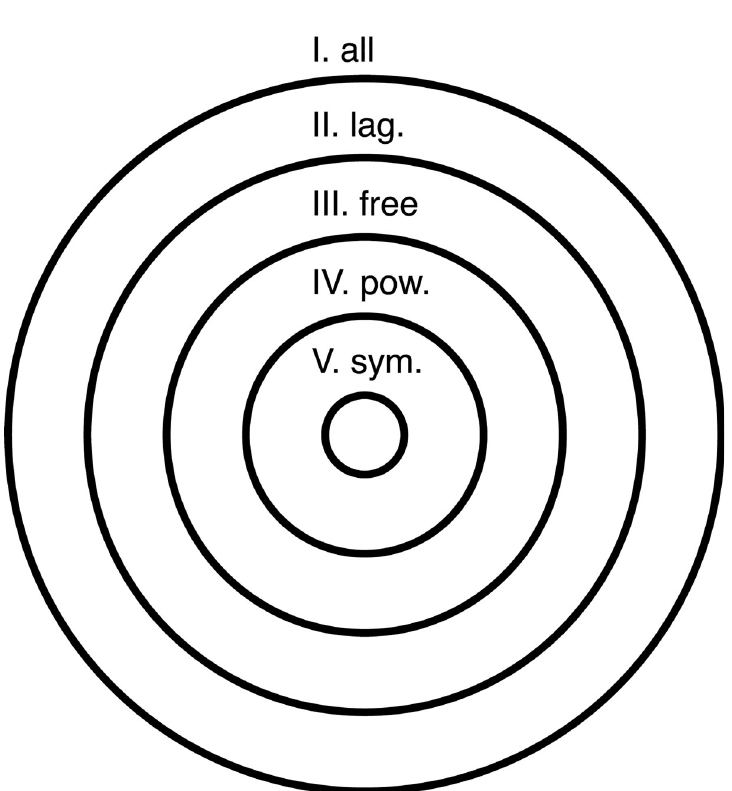
Fig 3. Scale-symmetric functions. In order of decreasing size, the areas of the circles represent the space of I. All possible functions; II. Functions that can be cast within a Lagrangian framework; III. Scale-free Lagrangians, IV. Scale- free Lagrangians that can be expressed as a power series; and V. Scale-symmetric power series Lagrangians. It is for this smallest subset of functions for which the quantities in (23) are conserved by virtue of scale symmetry.